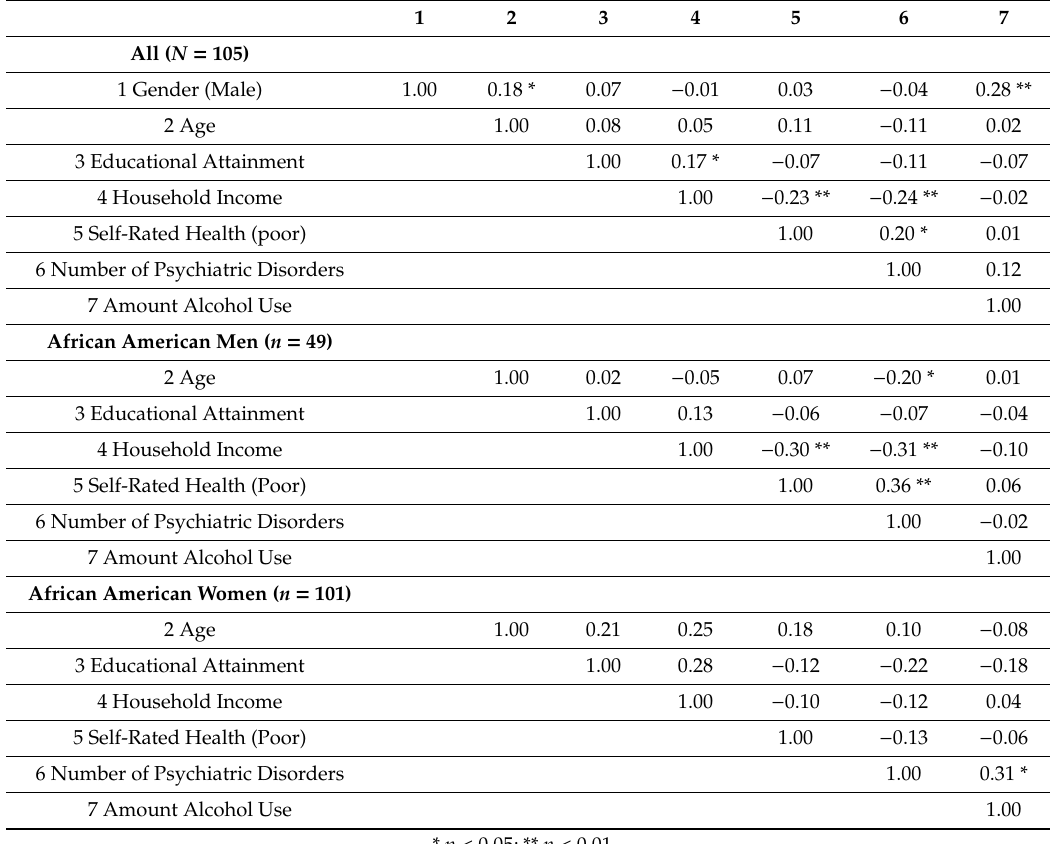
Table 2. Bivariate correlation matrix in the pooled sample and by